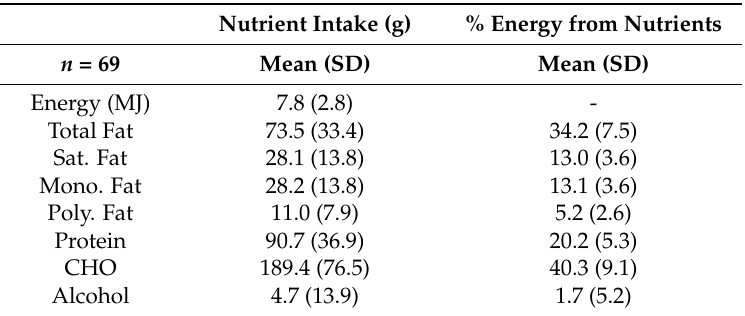
Table 3. Energy and nutrient intakes of study participants from the 24-h food